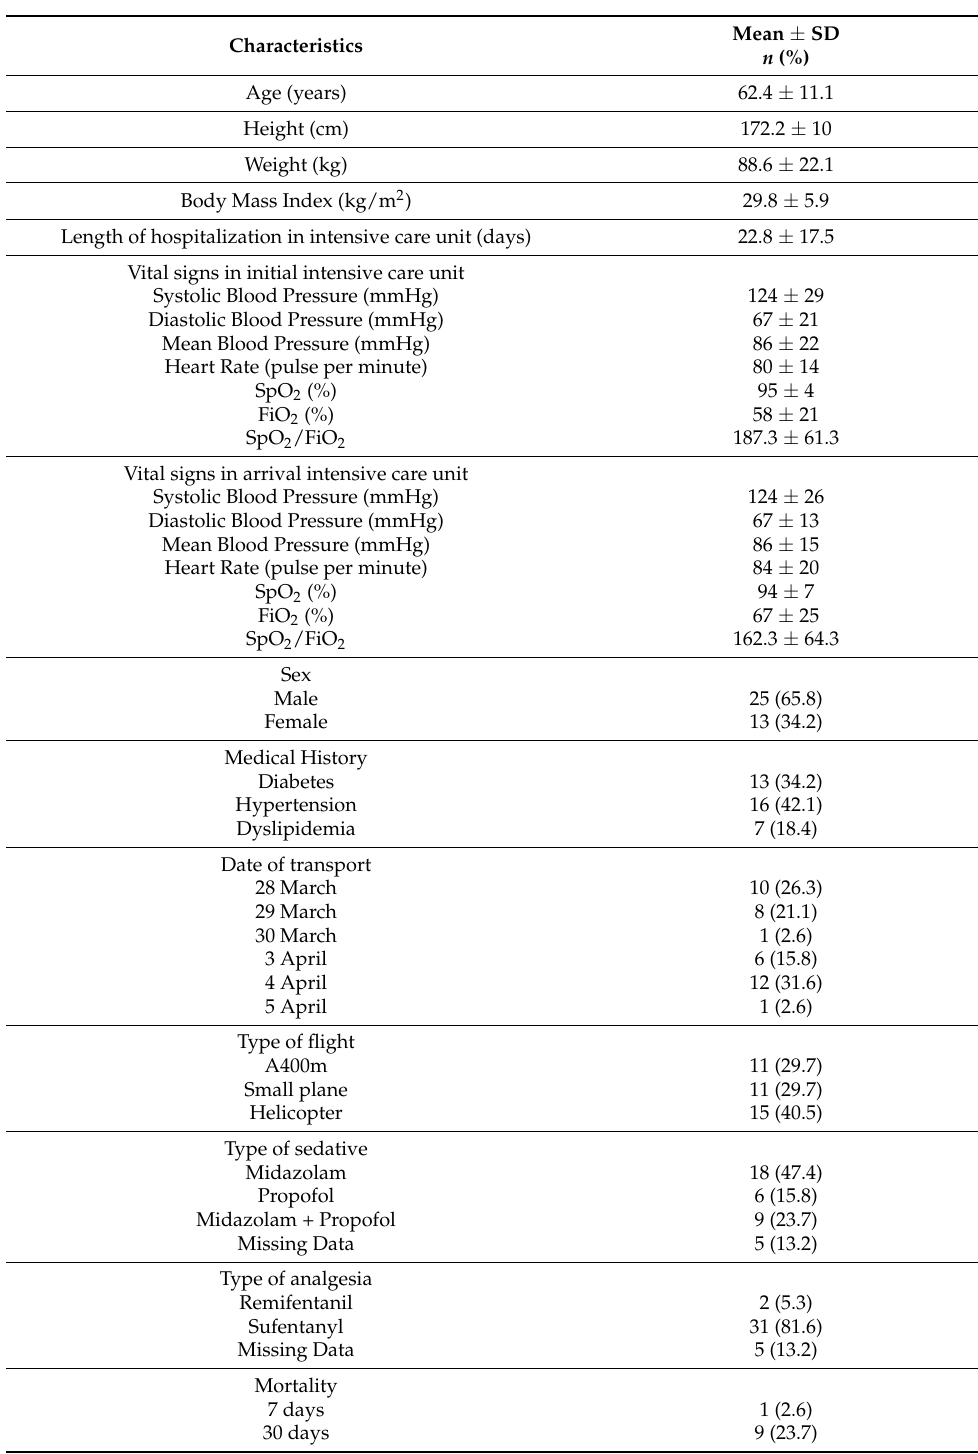
Table 1. Population characteristics. SD = standard deviation, n = number of patients, % = percentage, cm = centimeters, kg = kilograms, m 2 = square meters, mmHg = millimeter of mercury, SpO 2 = oxygen saturation, FiO 2 = percentage of